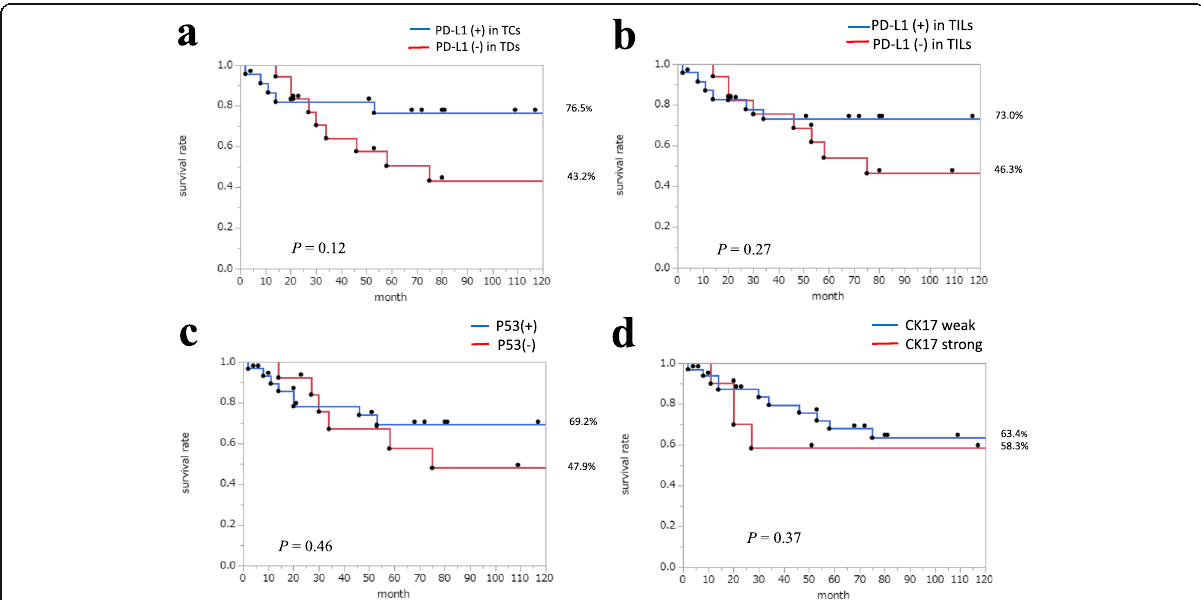
Fig. 2 Kaplan – Meier curve and long-rank test for 5-year disease-specific survival rate. a PD-L1 expression in TCs. b PD-L1 expression in TILs. c p53 expression. d CK17